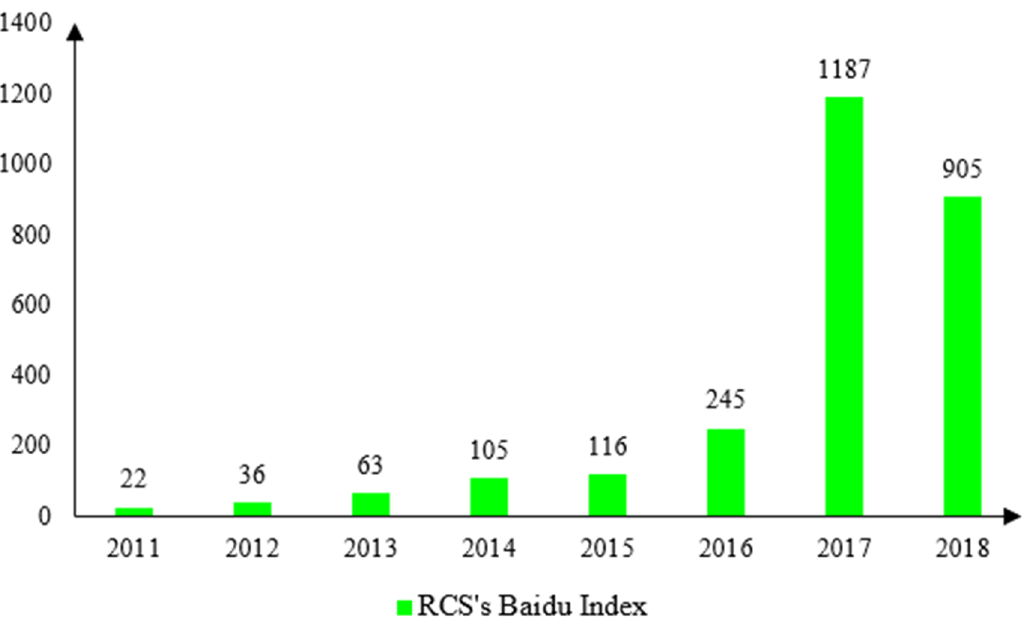
Figure 2. RCS’s Internet Search Index (Baidu Index).